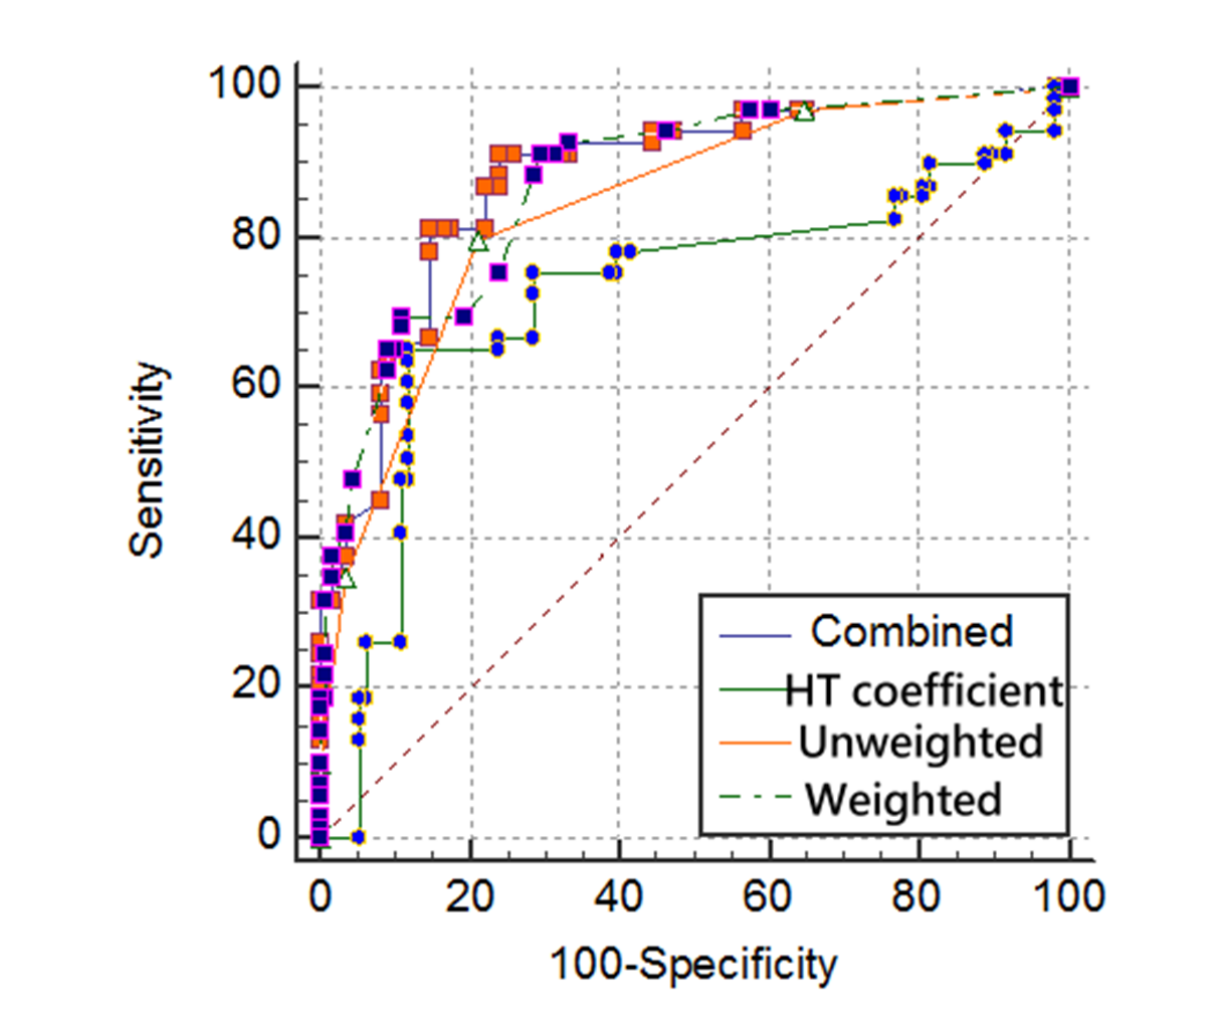
Figure 3. Four models plotted by receiver operating characteristic curves. The Combined denotes Model C in this study (sensitivity=0.87, specificity=0.84, area under the receiver operating characteristic curve=0.91,